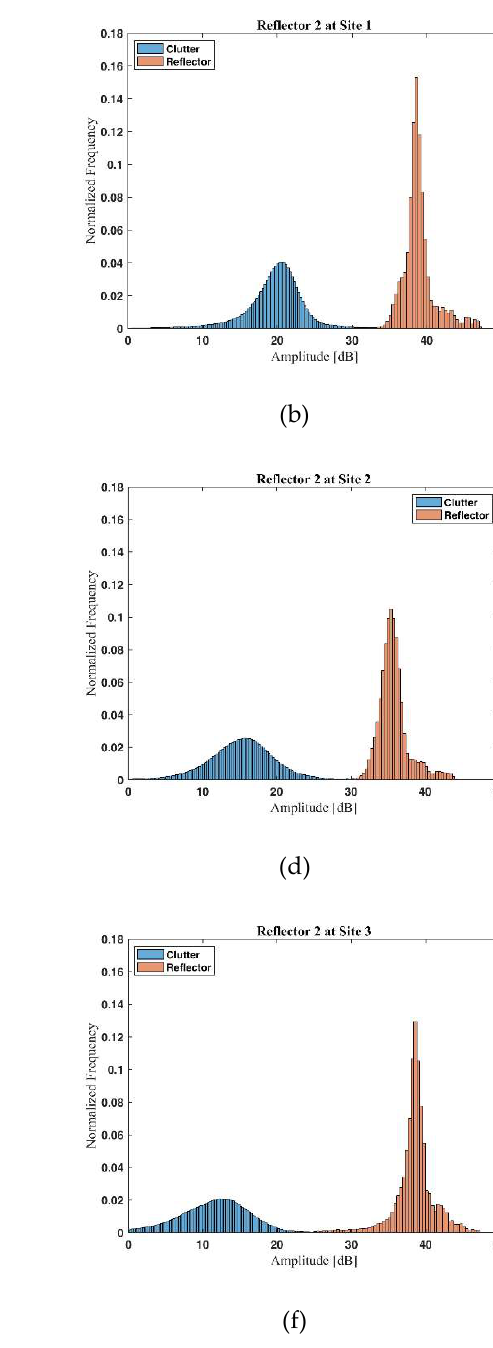
Figure 9. The variation of the amplitude reflects the signal-to-clutter level of each corner reflector. Panel ( a ) and ( b ) are from Site 1, panel ( c ) and ( d ) are from Site 2, and panel ( e ) and ( f ) are from Site 3. High signal-to-clutter level produces low variation. The amplitude of the backscattered energy from the reflectors shows a Rayleigh distribution as stated in [9], while the clutter from the mountain is normally distributed.